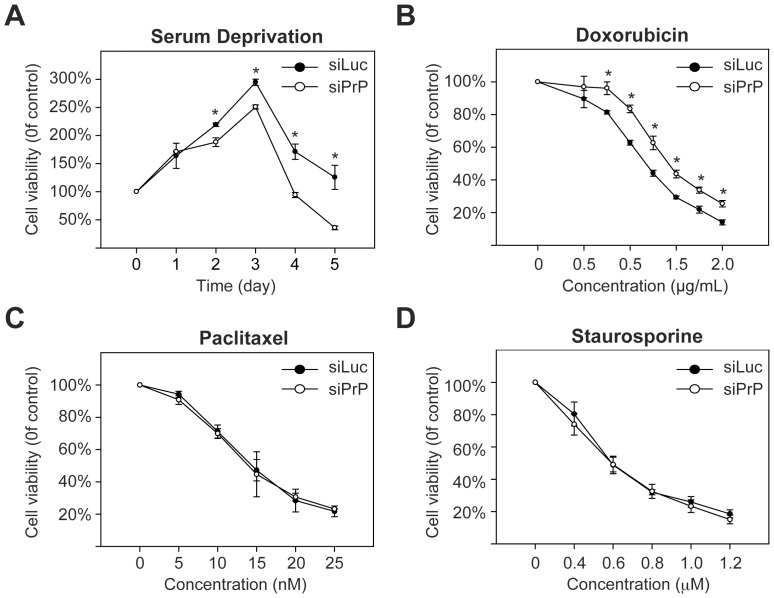
Responses of siPrP and siLuc cells to different cytotoxic stimuli.Cells were subjected to serum deprivation for 5 days (A), or incubated with doxorubicin (B), paclitaxel (C), or staurosporine (D) for 48 hours. Cell viability was measured by the MTT assay and the viability of cells without any treatment was set as 100%. Asterisks represent statistically significant differences, which were determined by student's t test and indicated by * P<0.05.